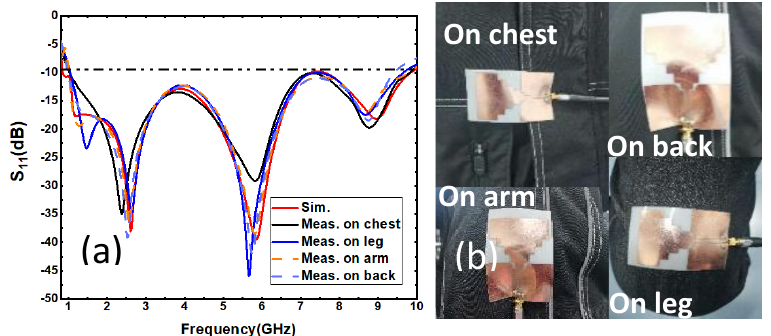
Figure 7. ( a ) Simulation results and S11 test results of different parts of the human body; ( b ) Test pictures of antenna fitting on human body parts.